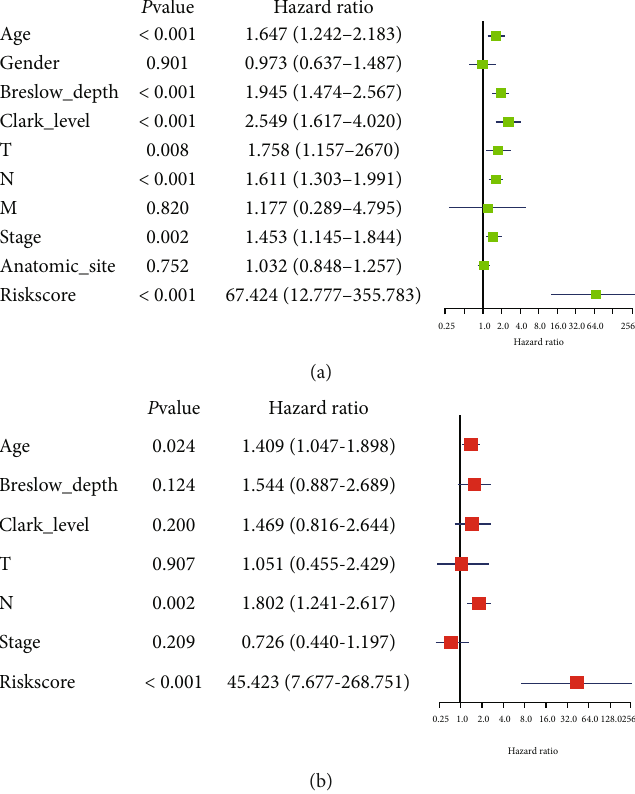
Figure 3: The univariate and multivariate Cox regression analyses of clinicopathological factors (including the risk score) and OS in the TCGA database. OS: overall survival. ∗ P < 0 : 05 , ∗∗ P < 0 : 01 , and ∗∗∗ P < 0 : 001